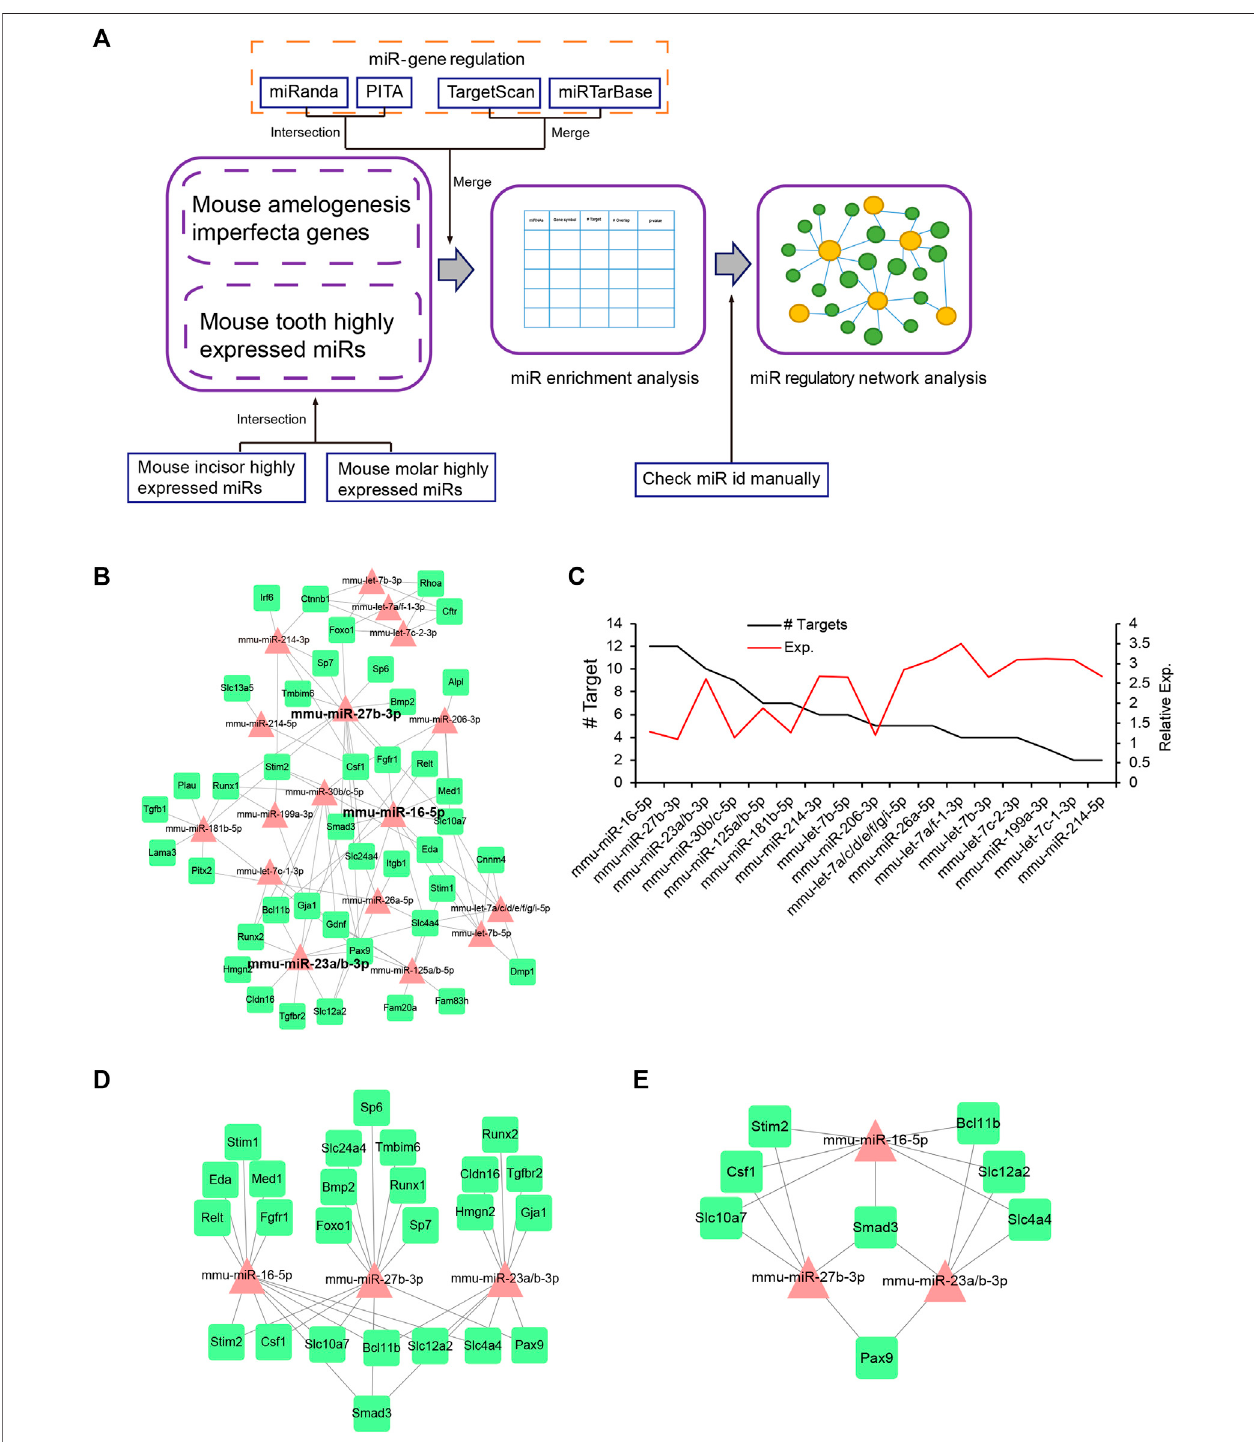
FIGURE 3 | miRNA-mAIGene regulatory network and features. (A) Flowchart of the miRNA regulatory network analysis. The miRNA-mAIGene pairs were fi rst identi fi ed using four miR-target databases with adjusted p -value < 0.05. Next, the miRNA regulatory network analysis was performed. (B) The miRNA regulatory network, which included 17 miRNAs, 41 mAIGenes, and 103 miRNA-mAIGene pairs. Three miRNAs (i.e., miR-16-5p, miR-27b-3p, and miR-23a/b-3p) were the hub miRNAs in the network. (C) Degree distribution of the miRNAs in the miRNA-mAIGene regulatory network in B, with miR-16-5p, miR-27b-3p, and miR-23a/b-3p having the highest degrees. (D) The sub-network of miR-16-5p, miR-27b-3p, and miR-23a/b-3p. (E) The sub-network of genes regulating more than two miRNAs in Figure 3D .